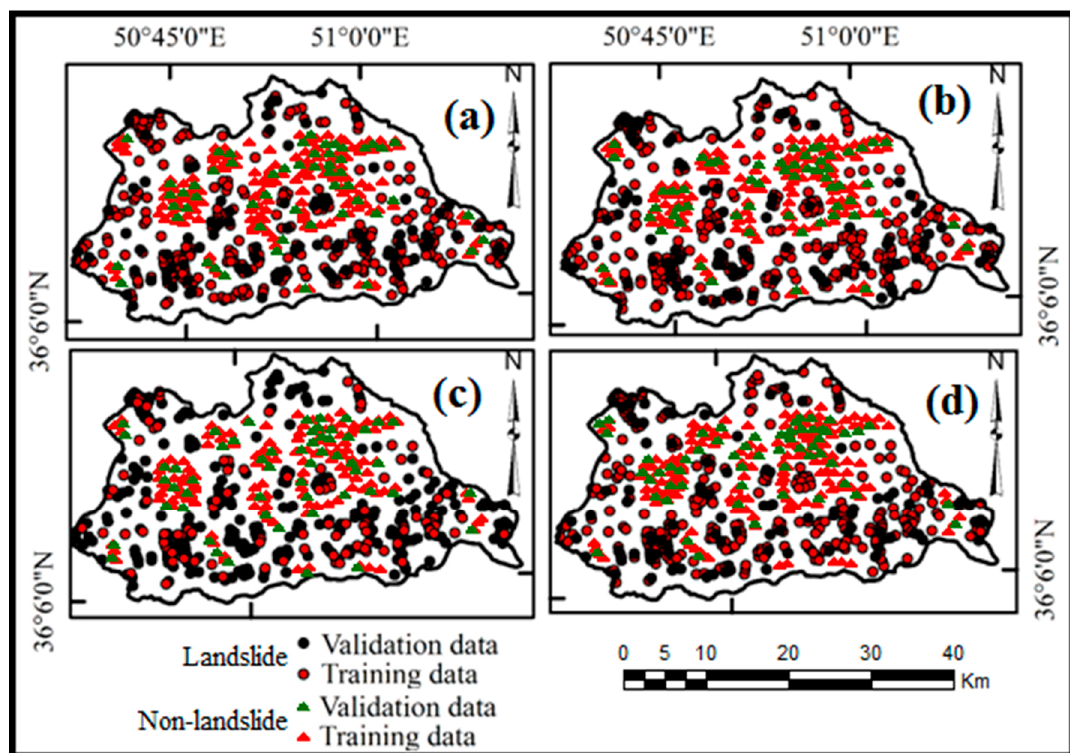
Figure 3. Landslide and non-landslide points of training and testing dataset using the four k-folds system ( a ) k1, ( b ) k2, ( c ) k3, and ( d ) k4.